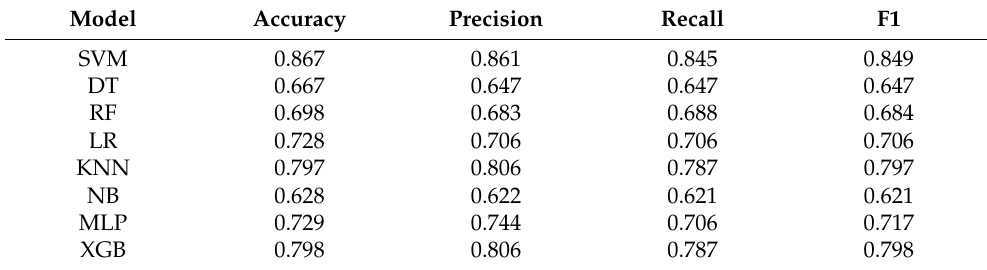
Table 5. Classifier results with dataset augmentation and without feature selection.